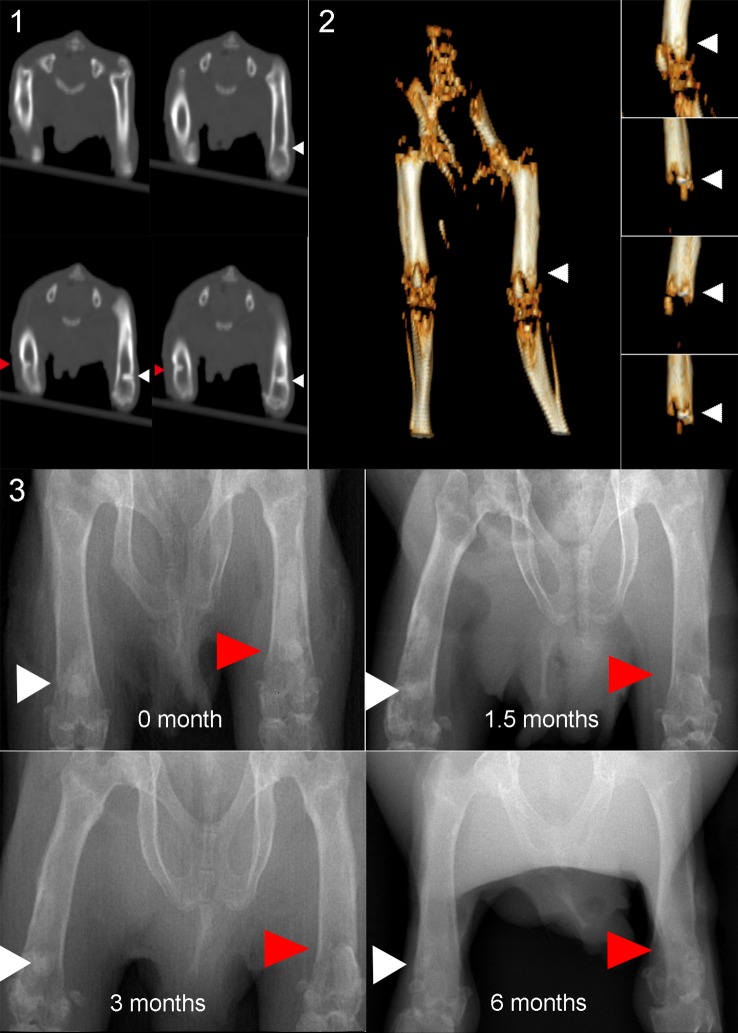
Computed tomography (CT) and radiography images showing cement sample integration with the host bone; a) CT image taken immediately after operation; b) 3D reconstructed CT image immediately after operation; c–f) radiographs taken 0, 1.5, 3, and 6 months, respectively.